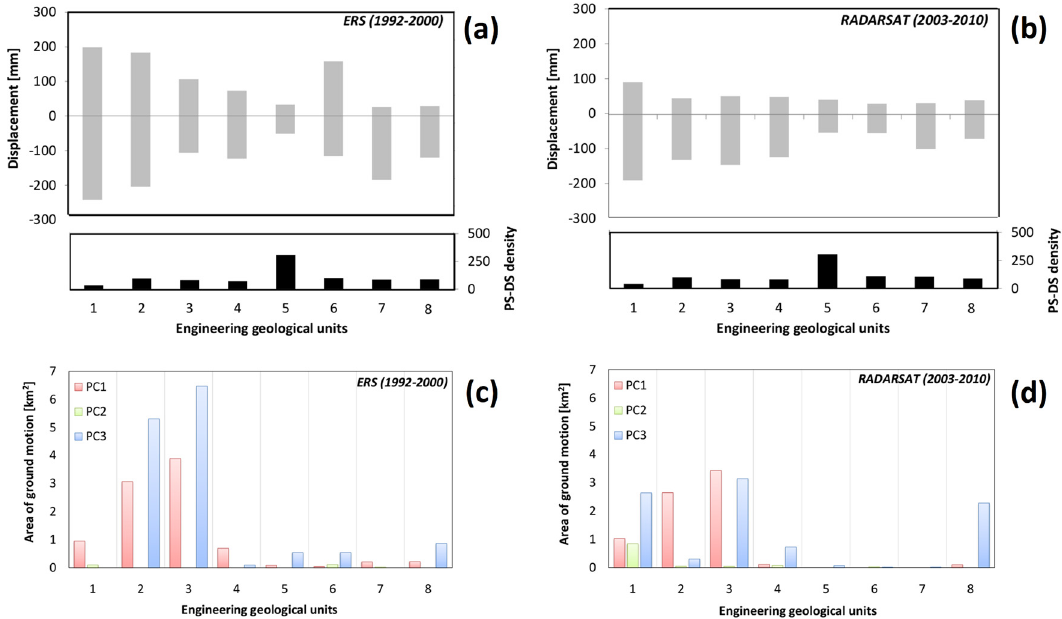
Figure 7. Cumulated displacement (mm) and PS-DS density (PS-DS/km 2 ) for the periods 1992–2000 ( a ) and 2003–2010 ( b ) for each engineering geological unit, which describes the geotechnical properties of the first 15 m of depth. See Figure 1 for the engineering geological unit map. Areas (km 2 ) of ground motion detected by PC1, PC2, and PC3 for each engineering geological unit, for the time intervals 1992–2000 ( c ) and 2003–2010 ( d ).